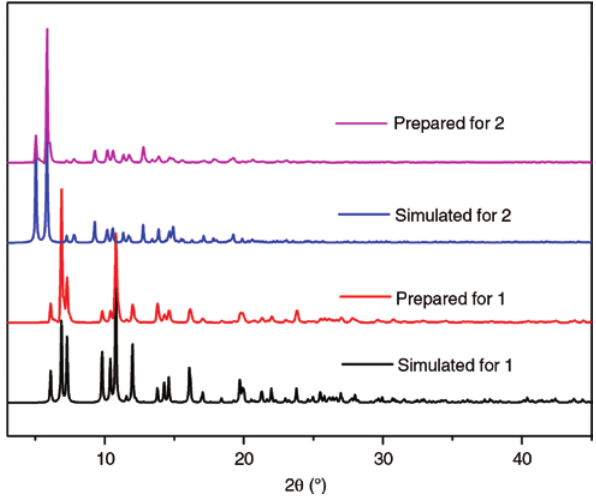
Figure 4: The simulated and experimental PXRD curves for complexes 1 and 2 .